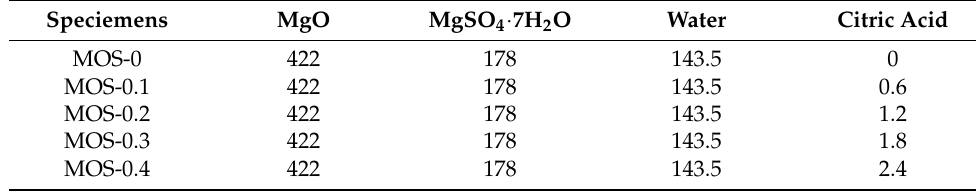
Table 1. The mixing proportions of MOS paste